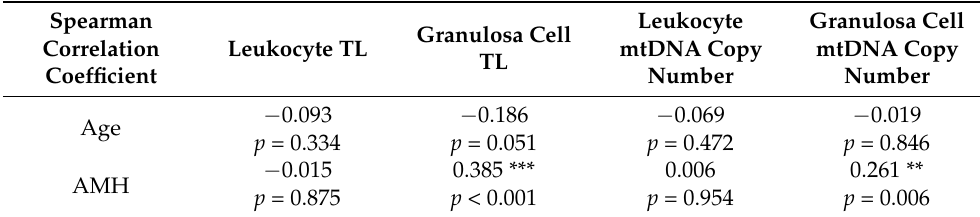
Table 2. Correlation between biomarkers of aging (Spearman correlation coefficient). mt denotes